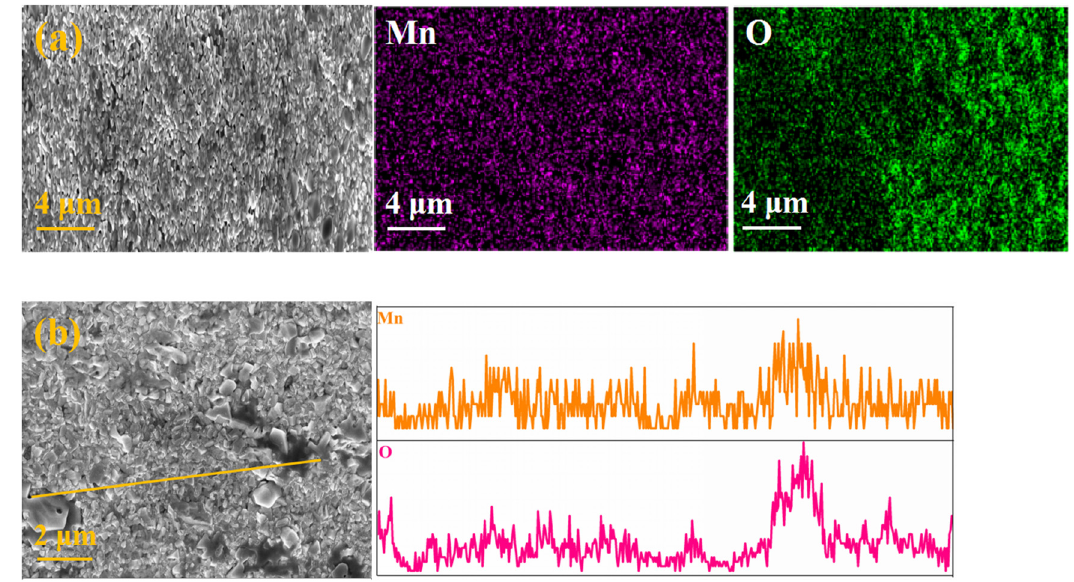
Figure 8: Picture of manganese volatiles by scanning electron microscope: ( a ) surface scanning graph and ( b ) linear scanning graph.